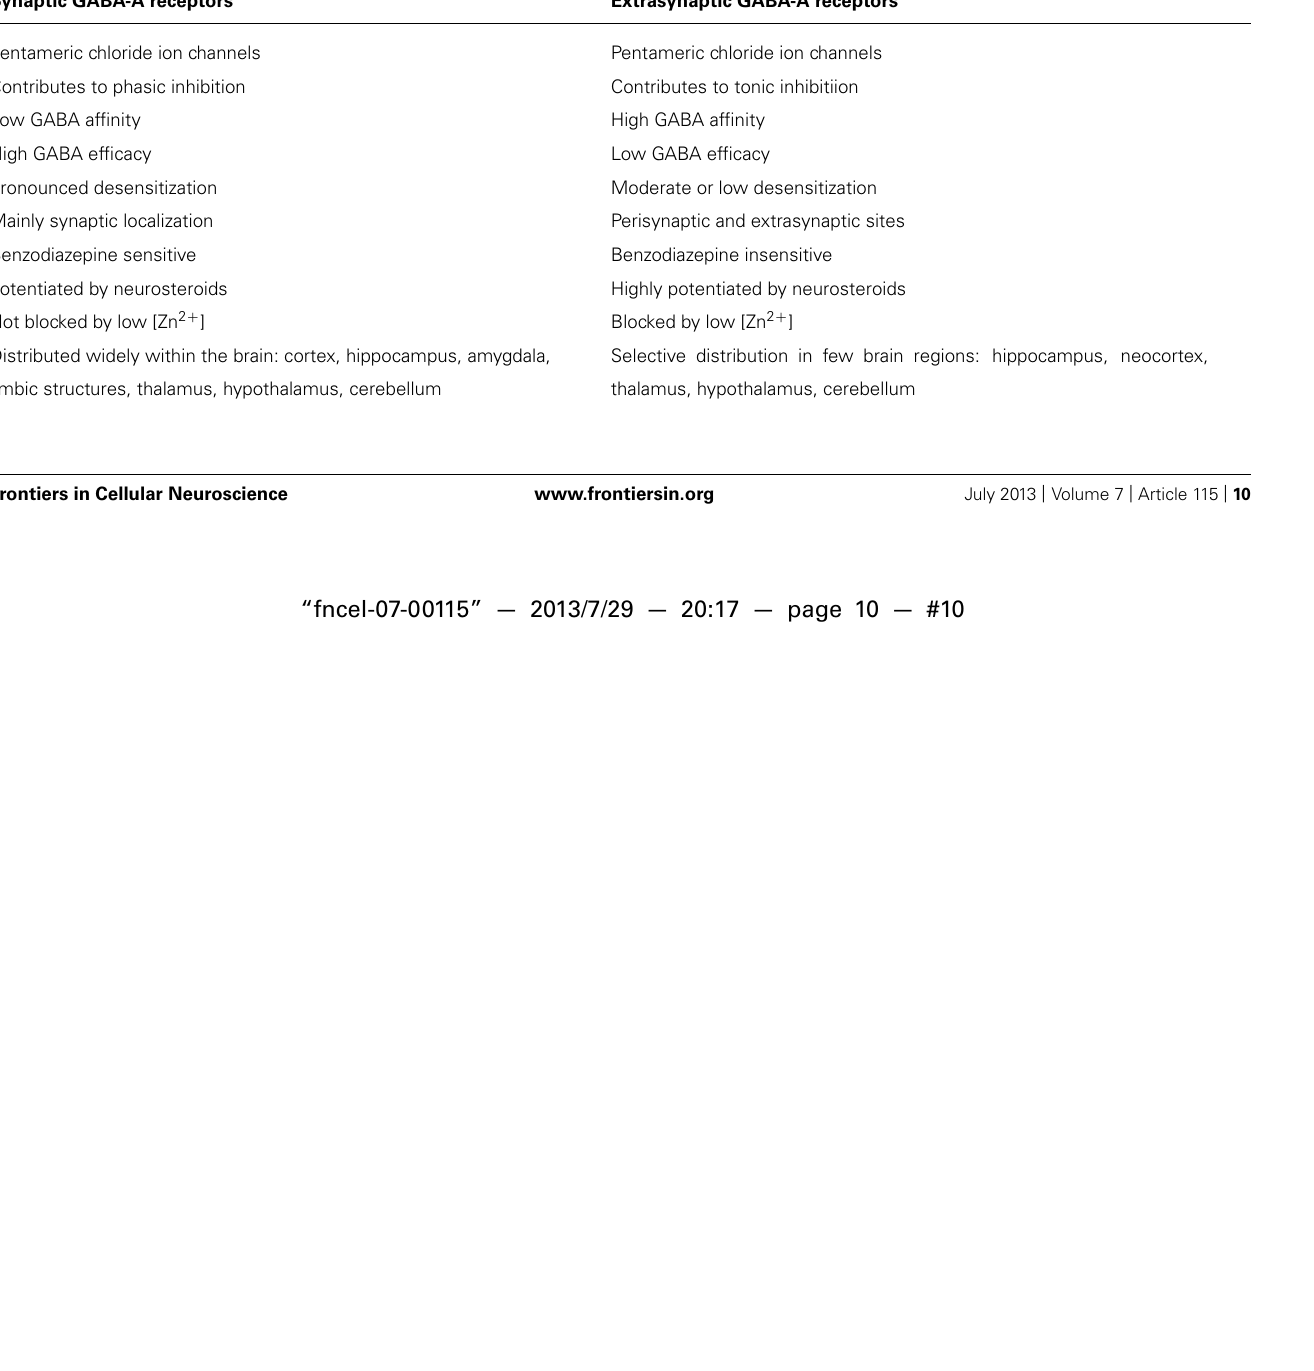
Table 3 |An overview of synaptic ( αβγ 2-containing) and extrasynaptic ( αβδ -containing) GABA-A receptors in the brain. Synaptic GABA-A